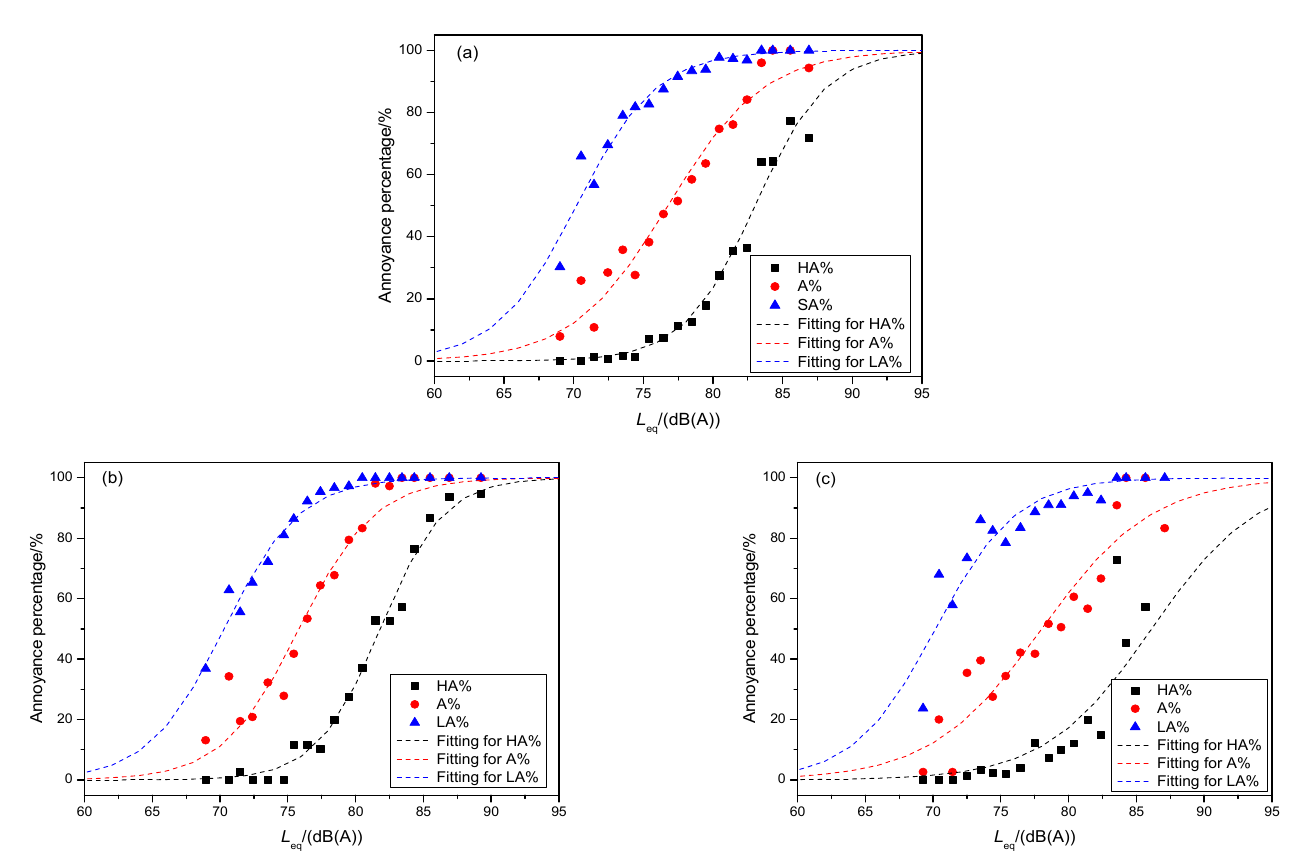
Figure 13. Fittings for the average values of annoyance percentages and equivalent SPLs: ( a ) for all samples of groups A and B, ( b ) for the samples of group A, and ( c ) for the samples of group B. The unknown parameters were obtained by fitting the average values using Equation (4), as listed in Table 3. Analysis of the values of adj-R 2 showed that the fitting evaluation result was similar to that in Table 3. The fitting result was best for the samples of group A and was worst for the samples of group B (this result was unacceptable). For the mixed samples of two groups, the fitting result was greatly affected by the contribution of group A. Table 3. Fitting parameters and evaluations for the relationship between annoyance percentage and SPL.